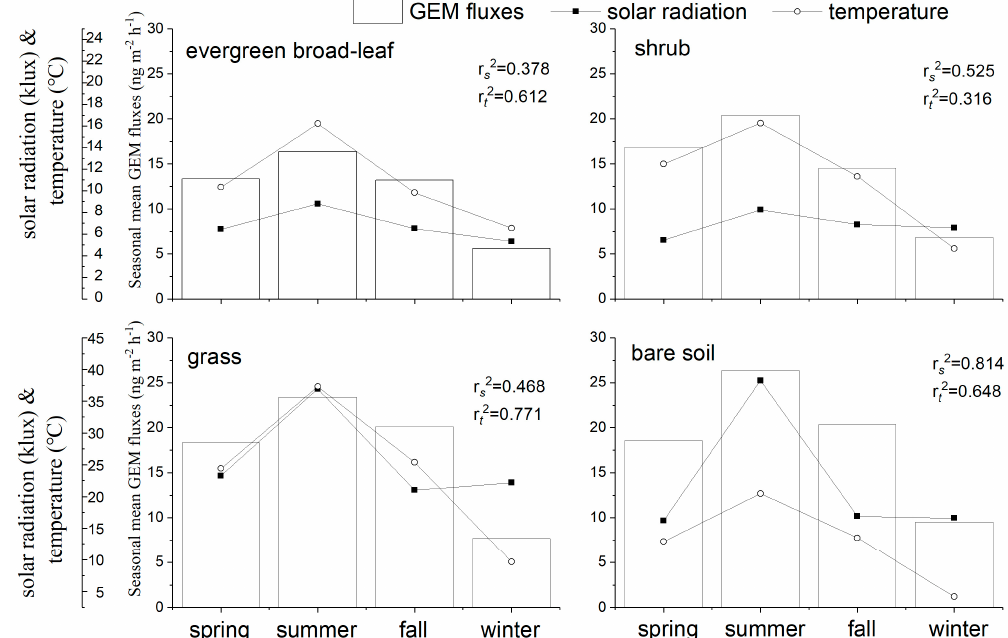
Figure 2. Effect of air temperature and solar radiation on GEM fluxes at the soil–air interface of the four vegetation covers during four seasons. The “r s ” and “r t ” means the statistical r values for solar radiation and temperature respectively.